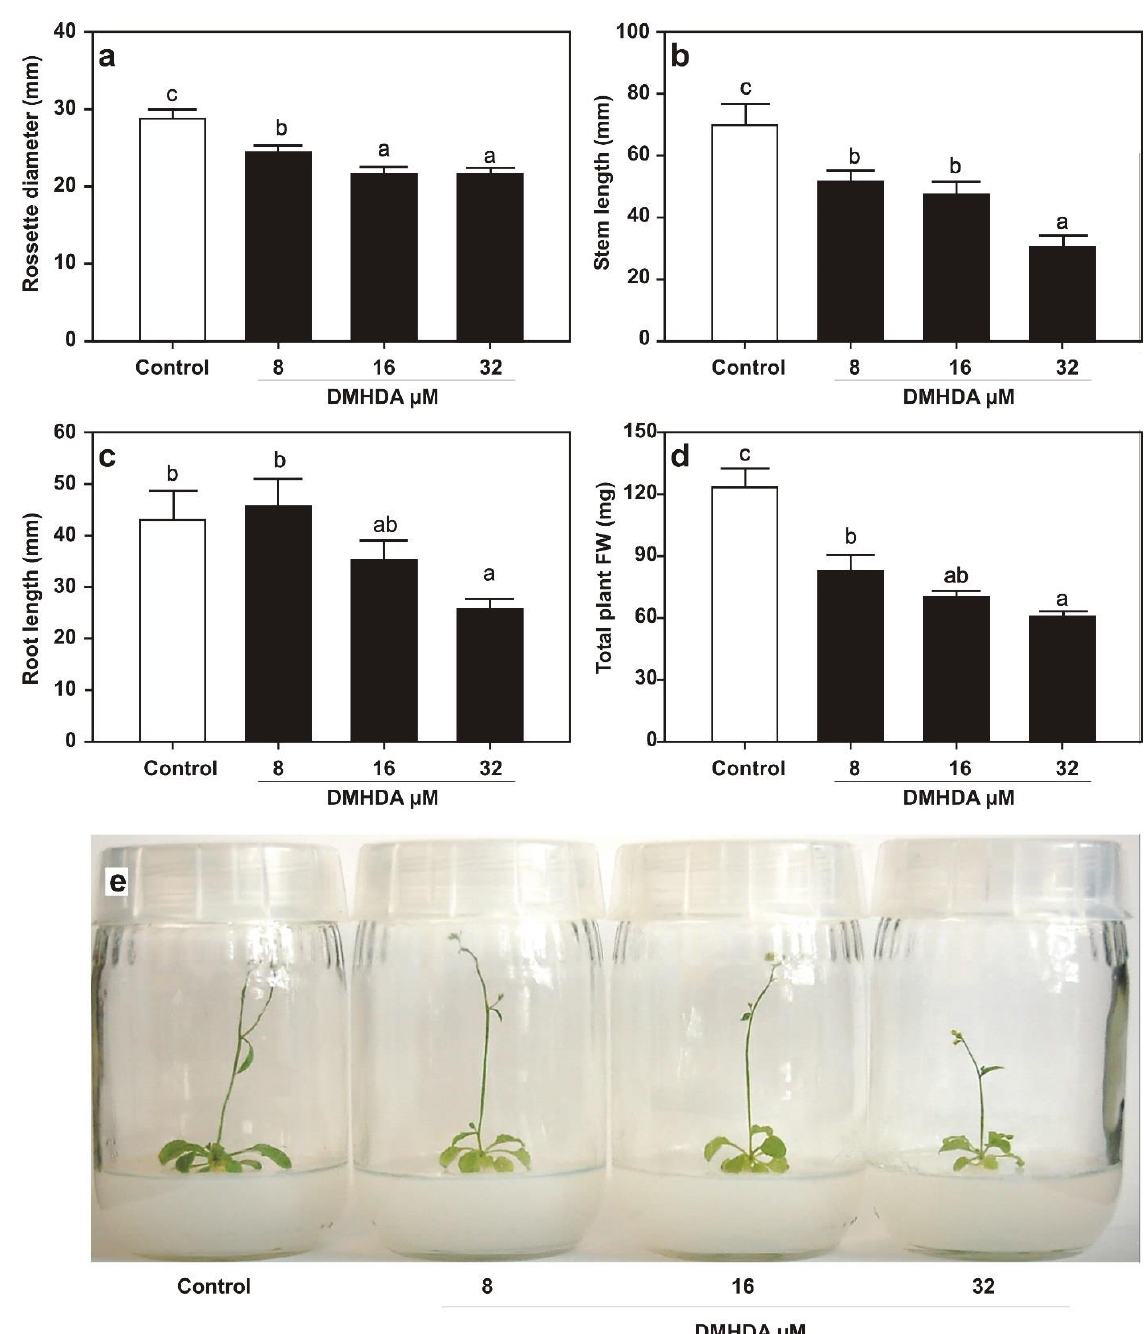
Figure 1. Effect of DMHDA on A. thaliana growth. Ten days after germination on Petri plates with 0.2X MS medium, seedlings were transferred to flasks with 0.2× MS medium supplied with 0, 8, 16, and 32 µM of DMHDA; eight days after transfer, phenotypical parameters were recorded: ( a ) Rosette diameter, ( b ) stem length, ( c ) root length, and ( d ) total plant fresh weight (FW). Panel ( e ) shows representative photographs of plants. Values represent the means of ten plants (one plant per flask) ± SE. Different letters represent statistically different means (Duncan’s test; p <